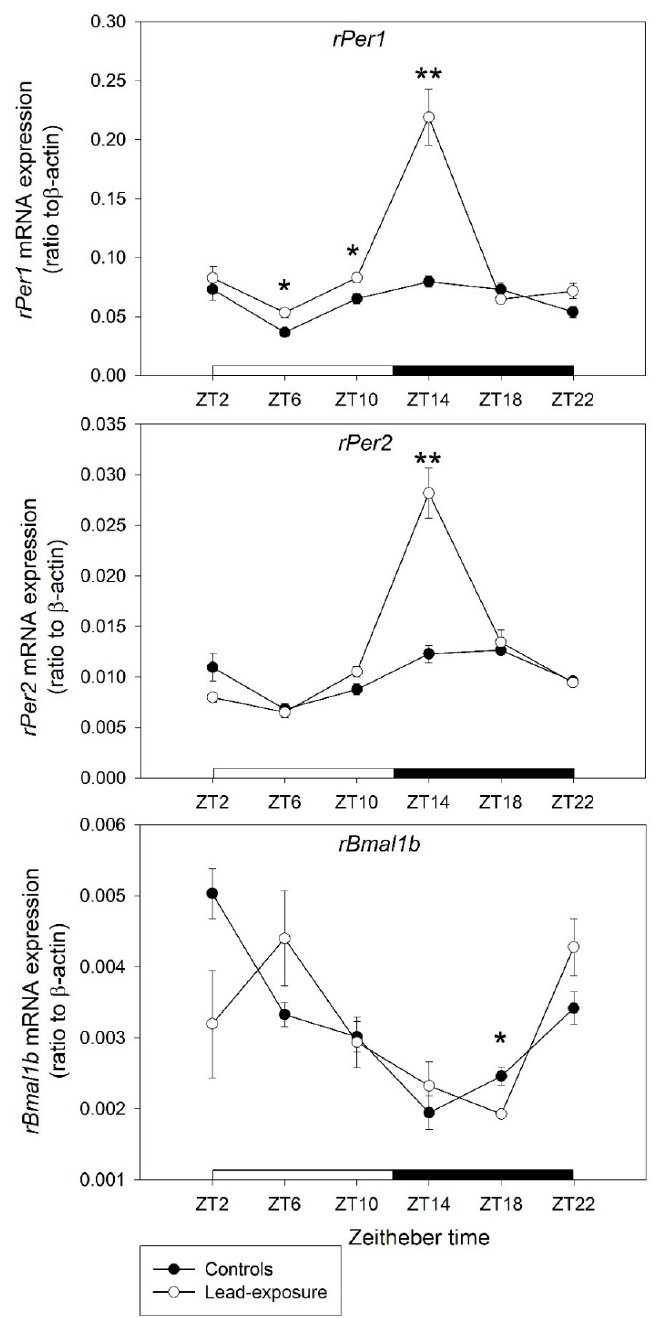
Figure 2. Clock gene mRNA expression in the hypothalamus between lead-exposure rat and control rats. Values on y-axis represent normalized as ratio of mRNA levels of clock genes to the housekeeping gene, β -actin. Values on x-axis represent circadian Zeitgeber time (ZT) points. Data are represented as mean ± standard deviation. * p < 0.05 and ** p < 0.01 versus the control group in Mann–Whitney U test.